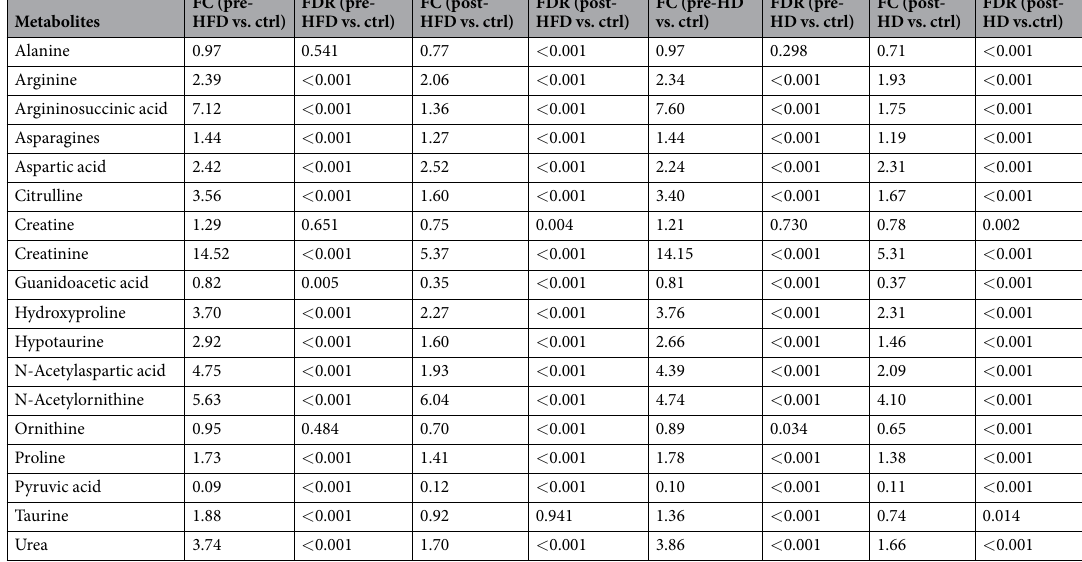
Table 2. Alterations of relative levels of 18 important metabolites in three